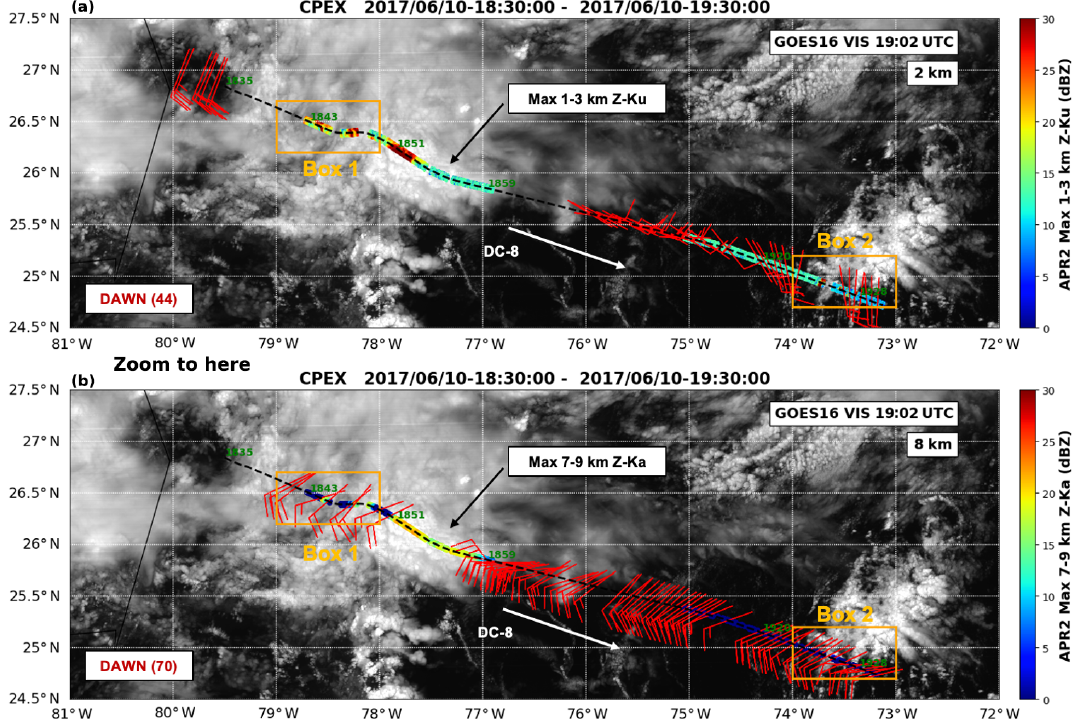
Figure 4. DC-8 flight line during segment 1 (18:30–19:30UTC) on 10 June 2017. The GOES-16 visible imagery at 19:00UTC is shown in the background grayscale (scaled from 0%–100% albedo, not shown). (a) The red barbs show the locations of the wind vectors (44 total) estimated by DAWN at 2km of height. The background color represents the average APR-2 Ku-band reflectivity between 1 and 3km of height (top color scale). (b) Same as panel (a) , but for an 8km height. The background color represents the APR-2 average Ka-band reflectivity between 7 and 9km (bottom color